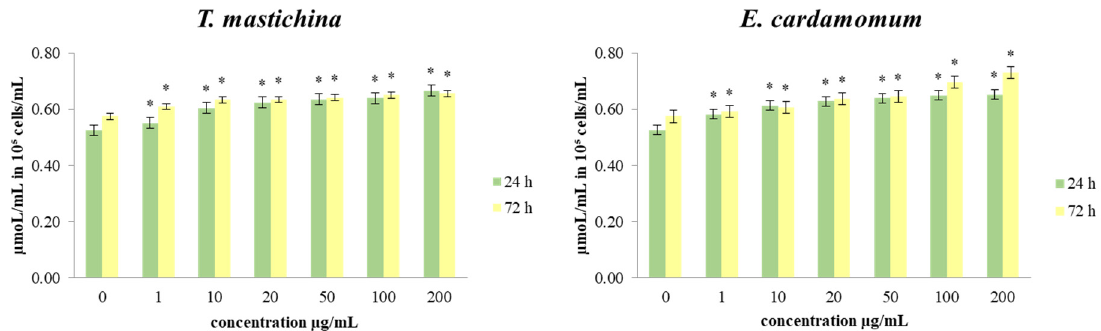
Figure 3. The effects of six concentrations of essential oils on the concentration of totGSH in MDA- MB-468 cells after 24 and 72 h of treatment. Results are presented as the mean of three independent experiments ± standard error; * p < 0.05 relative to